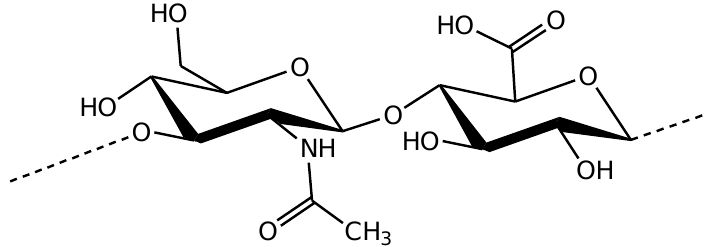
Figure 1. Chemical structure of the disaccharide unit of hyaluronic